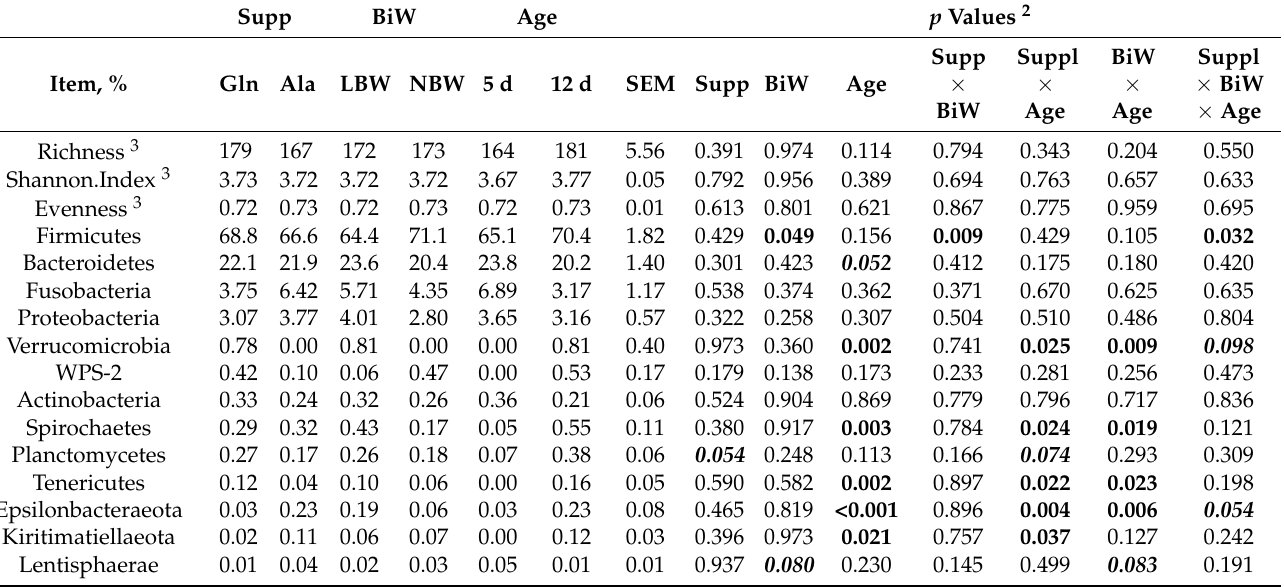
Table 4. Microbial diversity indices and relative abundance of bacterial phyla in the colon digesta of male suckling piglets 1